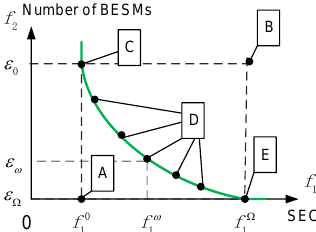
Figure 6. Points obtained by an (cid:101) -constraint